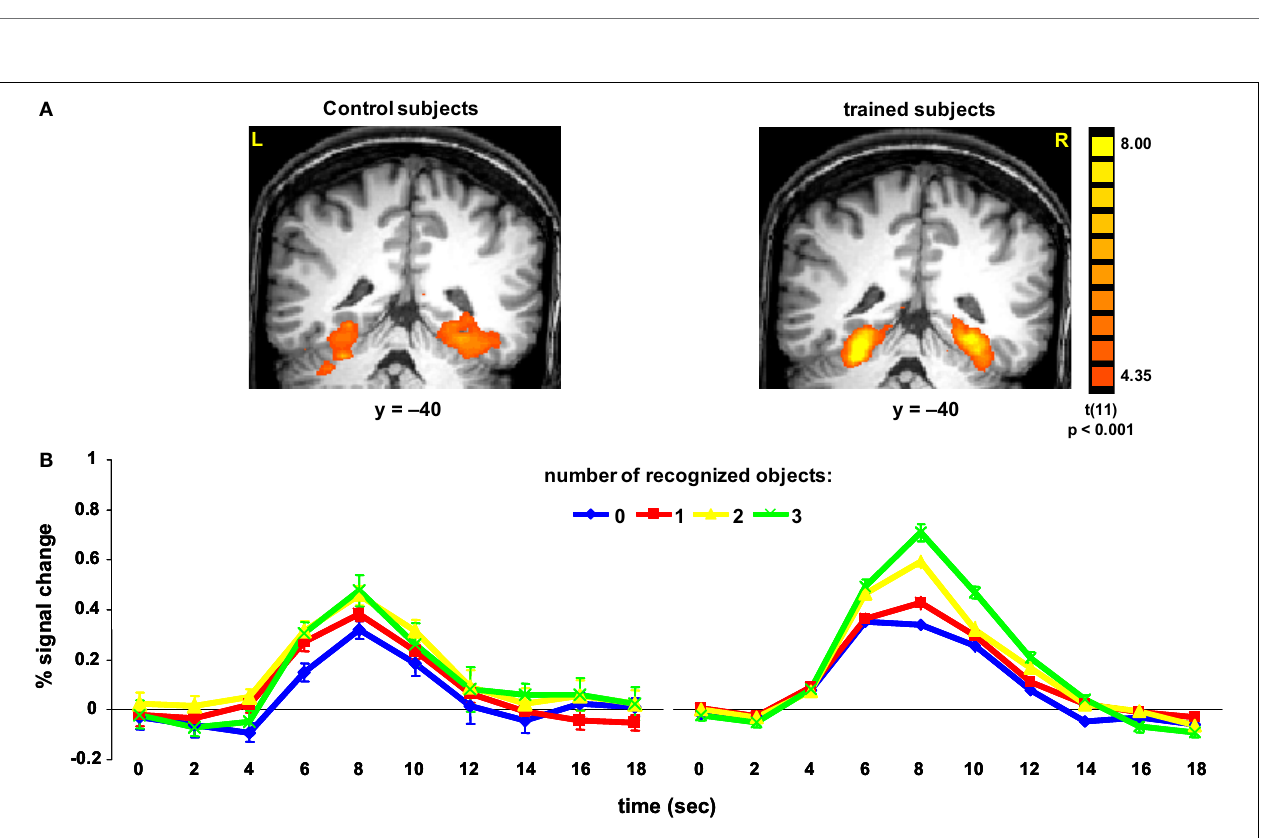
FIGURE 3 | Activation in parahippocampal cortex. (A) Group statistical maps, illustrating signifi cant activation in PHC for control (left) and trained (right) subjects. (B) Mean BOLD responses evoked when subjects reported recognizing 0, 1, 2, or 3 or more familiar objects in the paintings. Data were averaged across 12 subjects in each